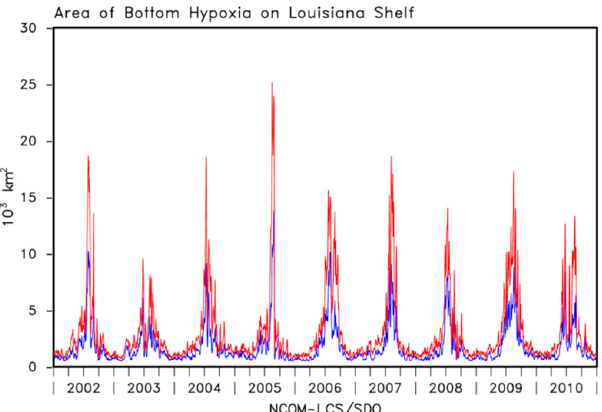
Figure 10. Area of bottom hypoxia on the Louisiana shelf simulated with Simplified Dissolved Oxygen (SDO) parameterization applying model physical parameters without satellite data (blue) and with satellite data (red).